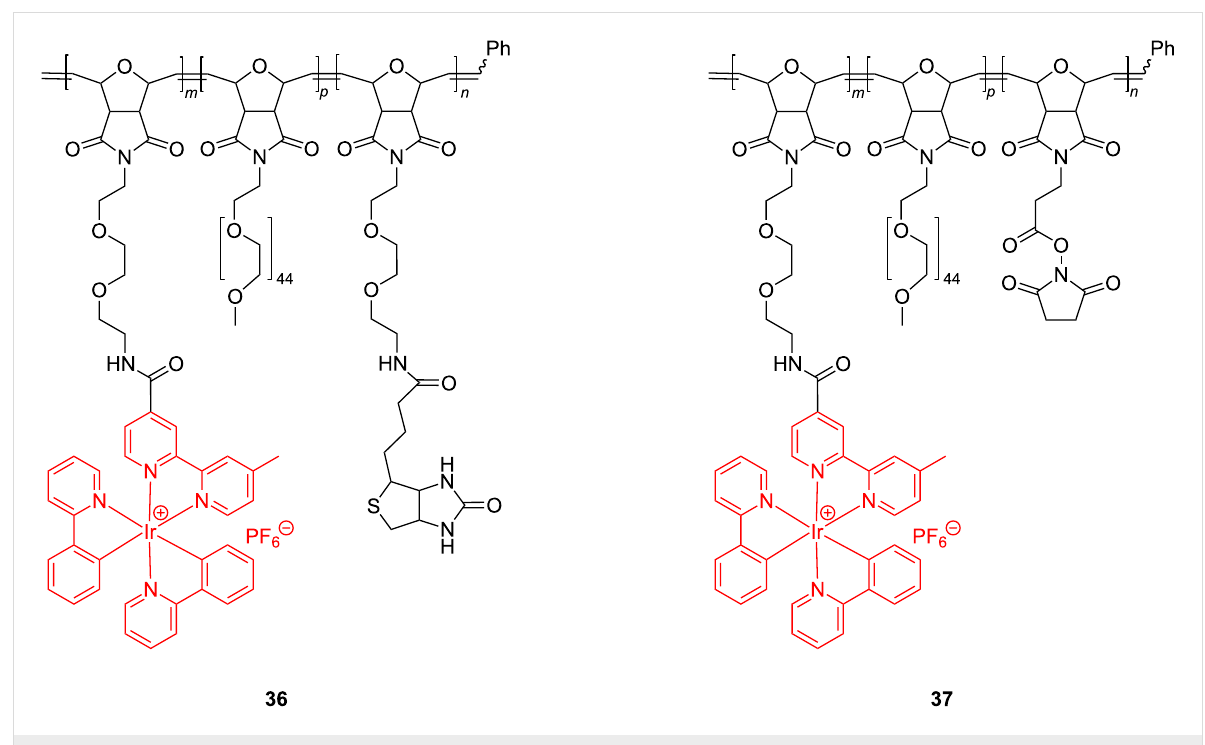
Scheme 15: ROMP block copolymers integrating Ir in their side